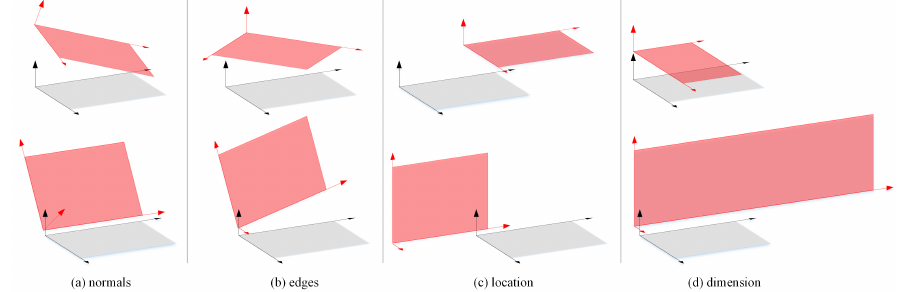
Figure 3. Criteria for opposite faces (the top row) and adjacent faces (the bottom row). The gray patch is a reference patch, and the red ones are patches that do not satisfy the ( a ) normal direction; ( b ) edge directions; ( c ) relative location or ( d ) dimension